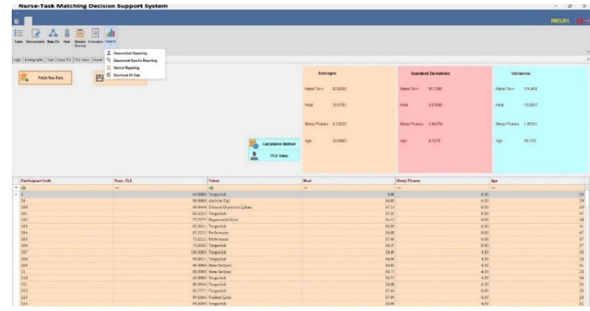
Fig. 6 PCA calculation screen